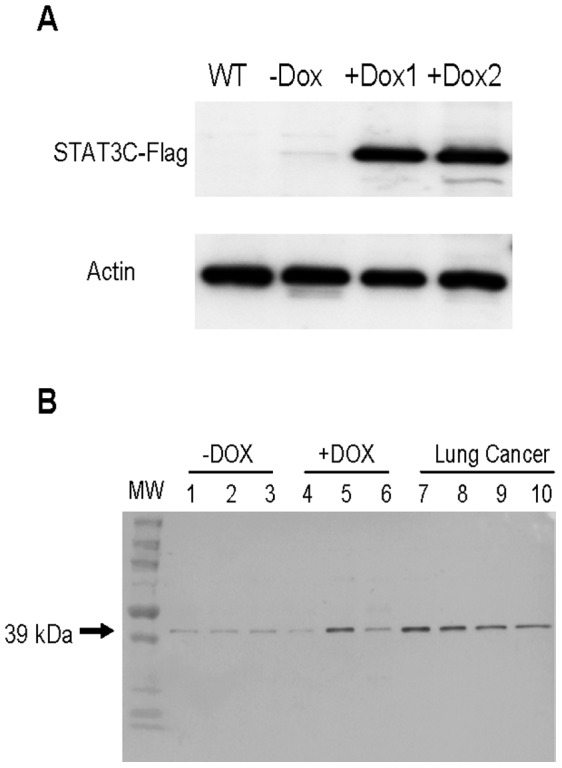
Western Blot analysis of Stat3C-Flag and CHI3L1 protein in CCSP-rtTA/(TetO)7-CMV-Stat3C mice.
A) Expression of Stat3C-Flag in the whole lung of CCSP-rtTA/(tetO)7-CMV-Stat3C double-transgenic mice. Actin was used as control. WT: wild type mouse lungs; -Dox: doxycycline untreated bouble transgenic mouse lungs; +Dox1 & +Dox2: doxycycline treated mouse lungs. B) Expression of CHI3L1 protein in BALF of CCSP-rtTA/(TetO)7-CMV-Stat3C double-transgenic mice. Lane 1–3, doxycycline-untreated mice (Dox-); Lane 4–6, doxycycline-treated mice without showing lung tumor (Dox+); Lane 7–10, doxycycline-treated mice showing lung tumor (Lung Cancer).